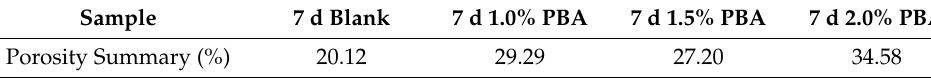
Table 7. Total porosity of cement sample at 7